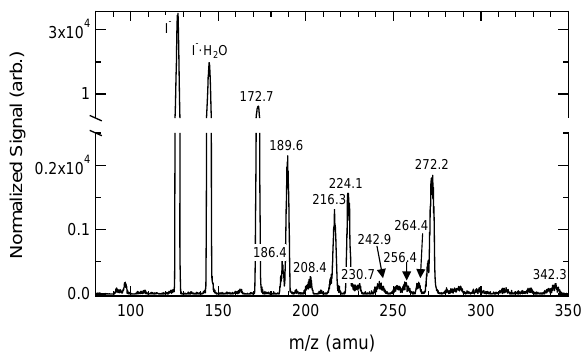
Figure 7. Aerosol-CIMS spectra of atomized solutions of 0.5 M acetaldehyde/MG Fig. 7. Aerosol-CIMS spectra of atomized solutions of 0.5M ac- (1:1) in 3.1 M AS. See the text for details of sample preparation and analysis. Posi- etaldehyde/MG (1:1) in 3.1MAS. See the text for details of sam- ple preparation and analysis. Positive-ion mass spectrum using tive-ion mass spectrum using H 3 O + ·(H 2 O) n as the reagent ion. H 3 O + · (H 2 O) n as the reagent ion.